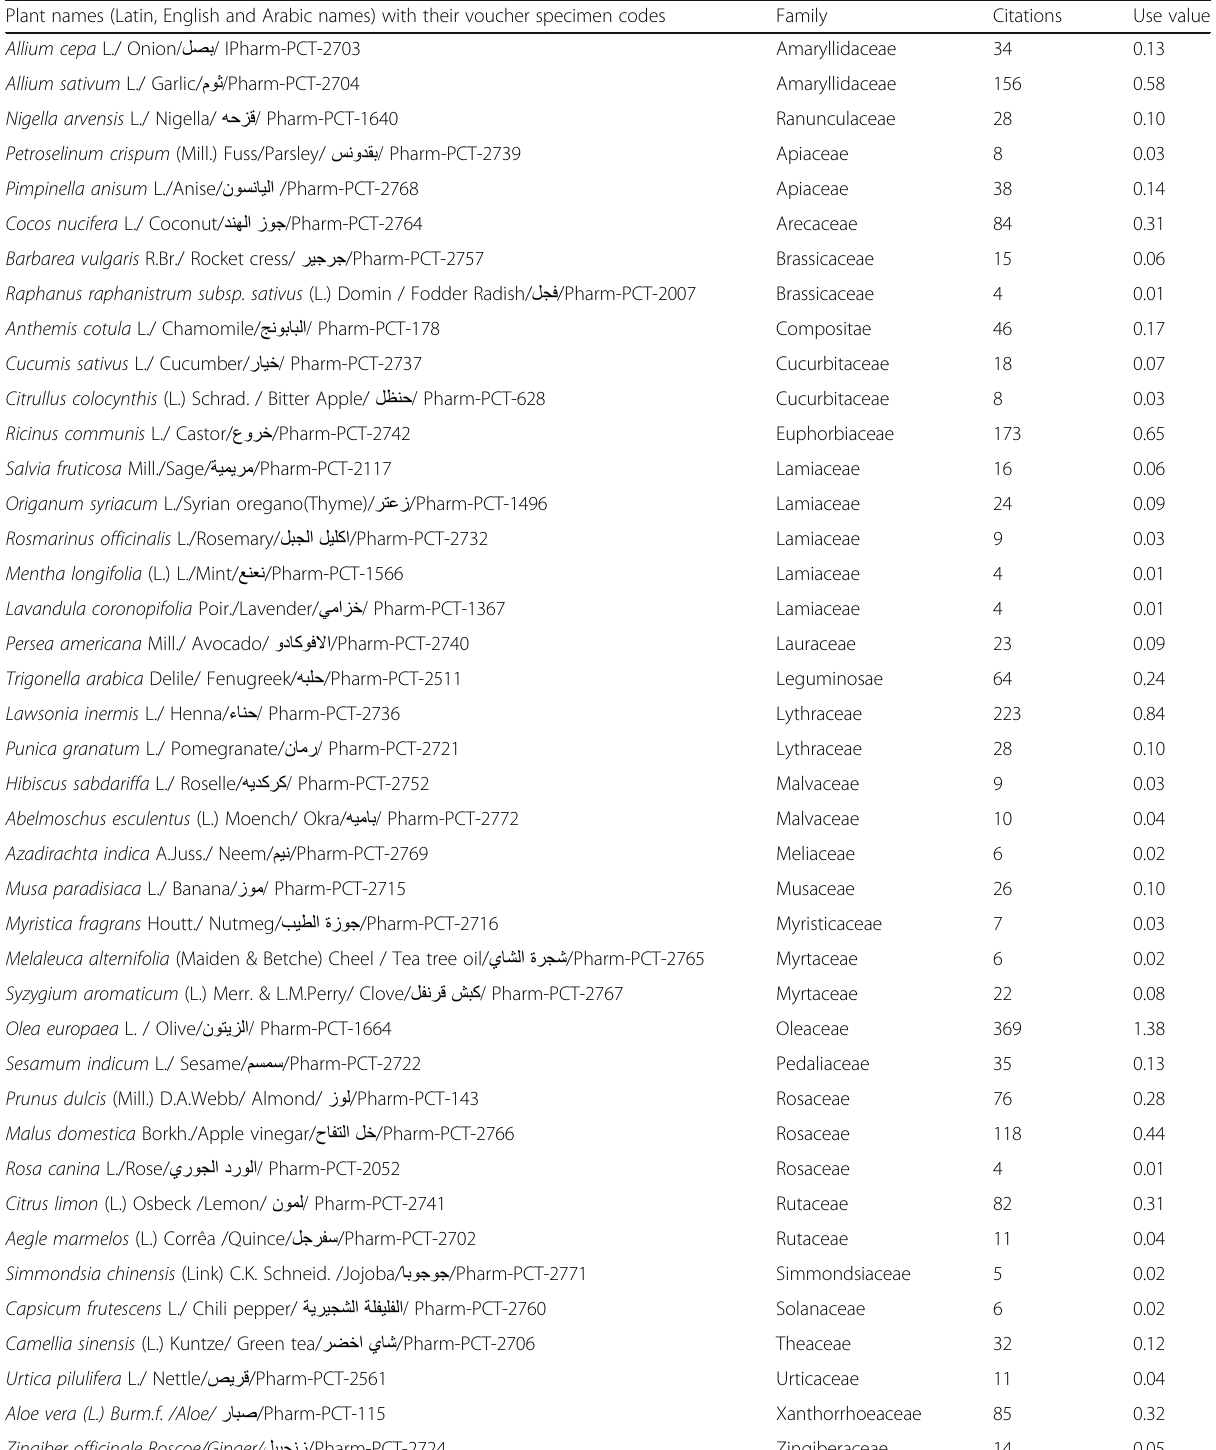
Table 2 Herbals used in the treatment of hair and scalp in the West Bank/Palestine Plant names (Latin, English and Arabic names) with their voucher specimen